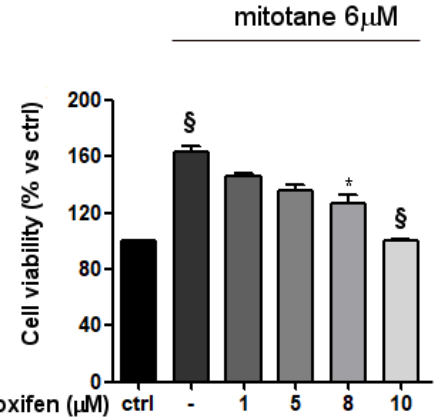
Figure 4. Tamoxifen antagonizes mitotane effect on MCF-7 cell viability. ER-α-positive MCF-7 cell line was pretreated for 1 h with increasing concentrations of tamoxifen as above described, then mitotane 6 µM was added to the medium. Cell viability was measured by MTT assay after three days of treatment. Results are expressed as percentage of viable cells ± SEM vs. untreated cells (ctrl). Data are the mean of three different experiments, each point run in triplicate. § p < 0.0001 vs. ctrl; * p < 0.001 vs. mitotane 6 µ M treated cells without